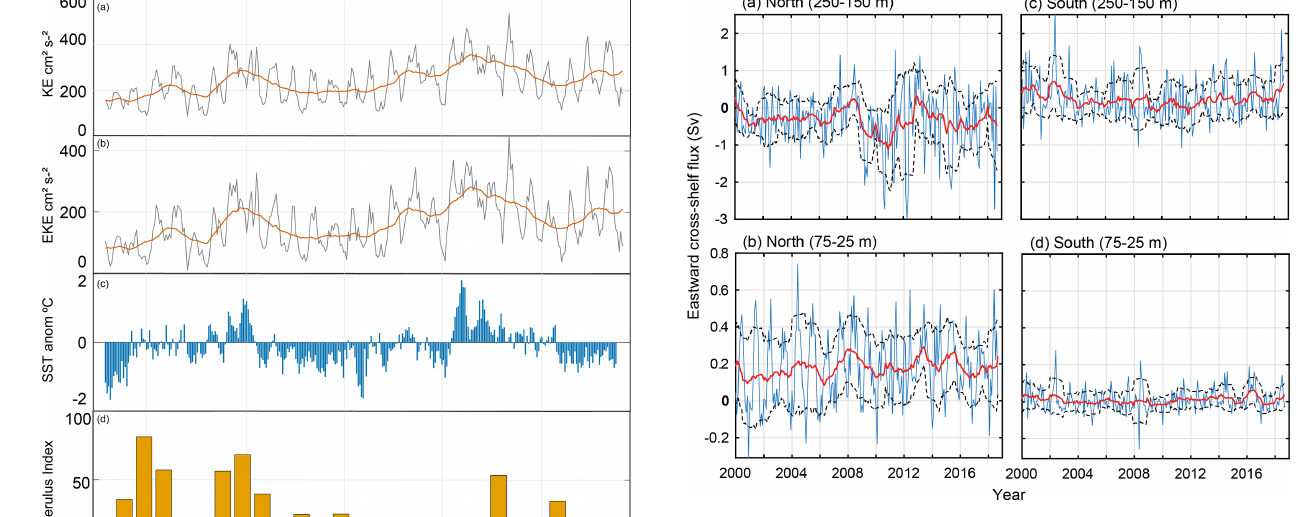
Figure 12. Cross-shelf transport (easterly) between 2000 and 2018 off the shelf. North and south divides are shown in Fig. 1a. North cross-shelf flux between (a) 250–150m and (b) 75–25m. South cross-shelf flux between (c) 250–150m and (d) 75–25m. The yearly moving mean (red) and the positive and negative moving standard deviations (dashed black) are included.